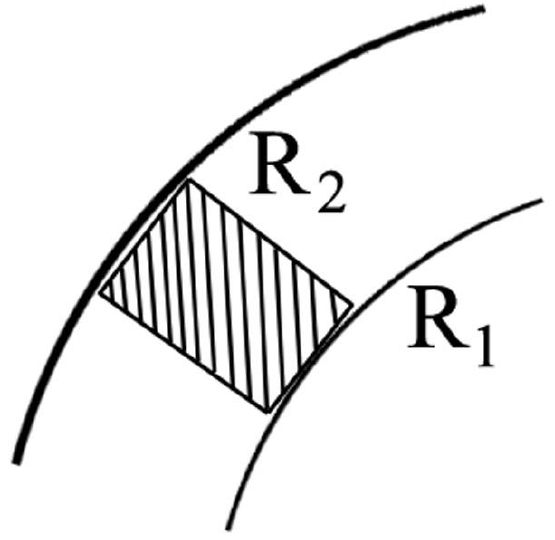
Figure 3. Count concentration geometry. R1 and R2 are radii of older and younger tree rings, correspondingly. Count concentration is calculated per mm 2 of the dashed rectangle with a width of 2 mm (width of the scanning beam). Count quantity is calculated for the area between R1 and R2 circumferences.